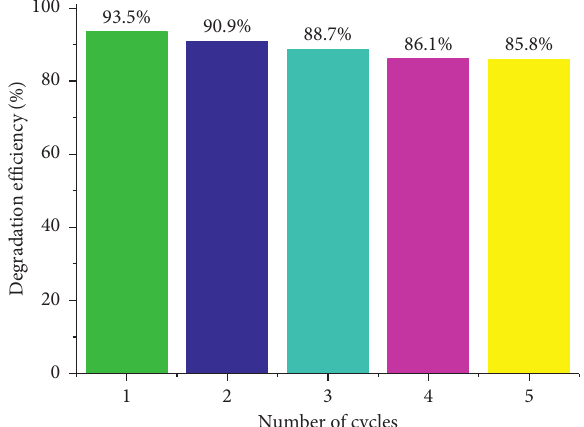
Figure 28: MB photodegradation efficiencies measured during the five treatment